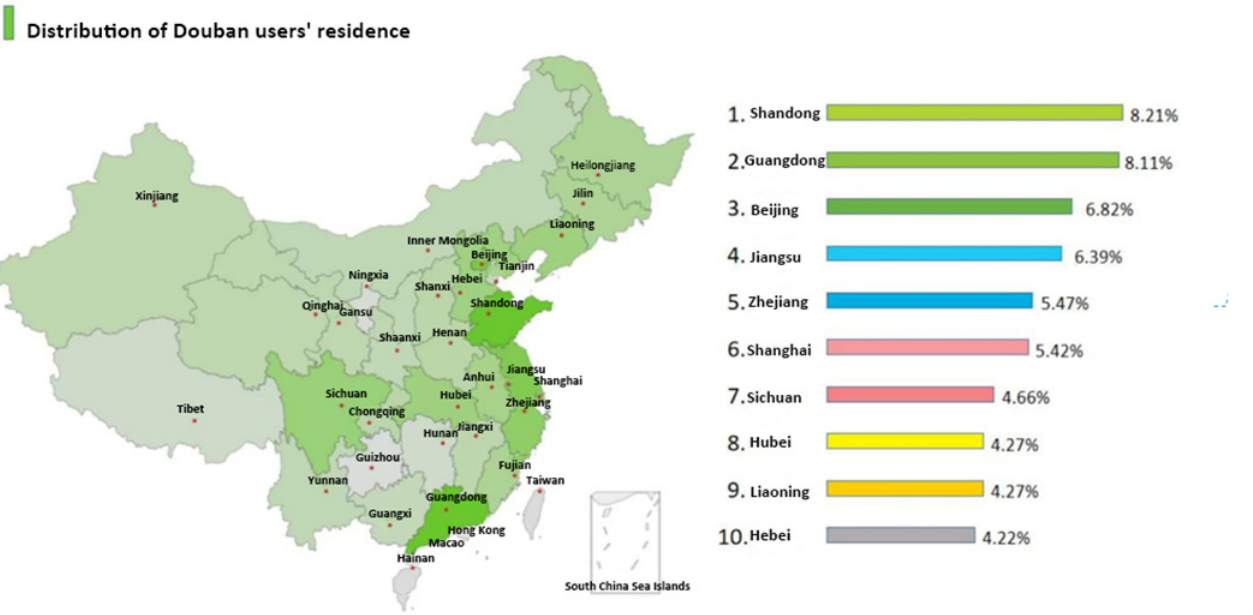
Table 1. Site ratings for four Buddhist movies 4 .